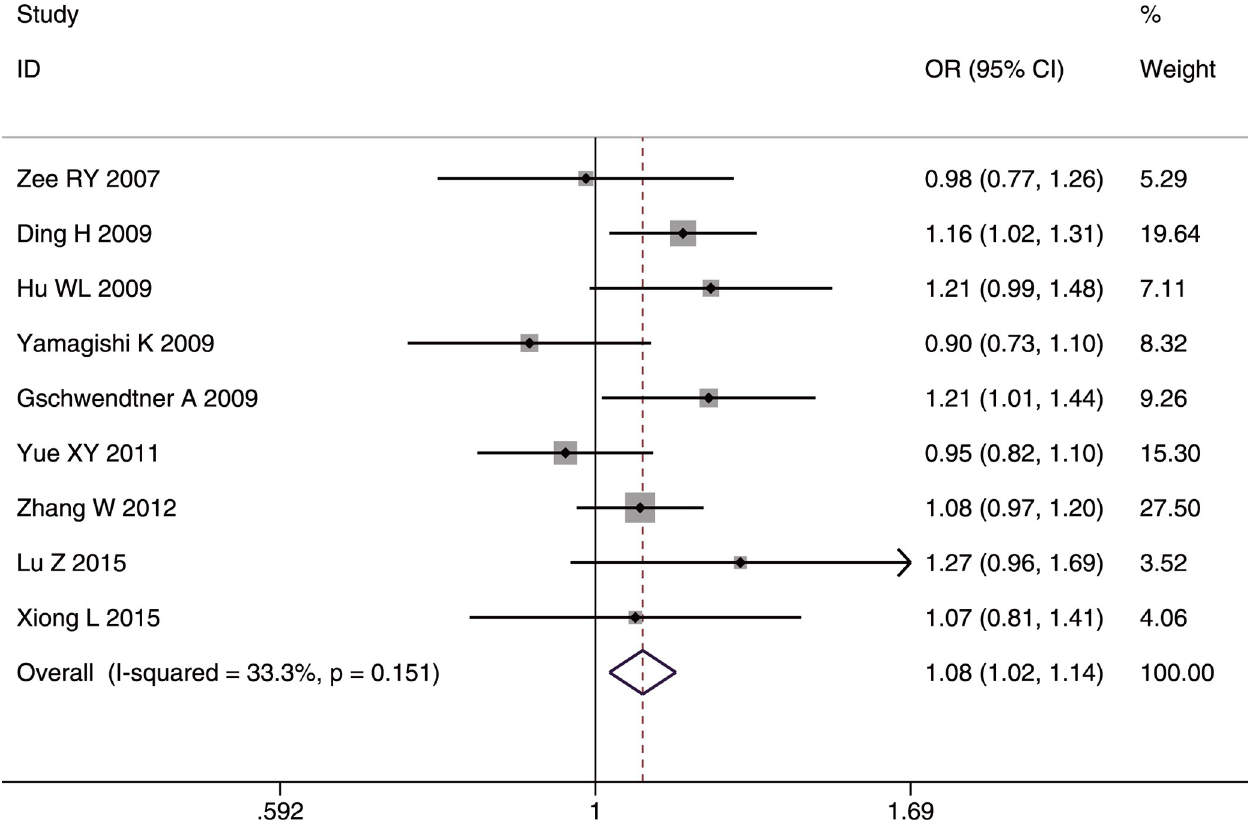
Fig 6. Forest plot of rs2383206 allele frequency (G vs. A) in the whole studied population.